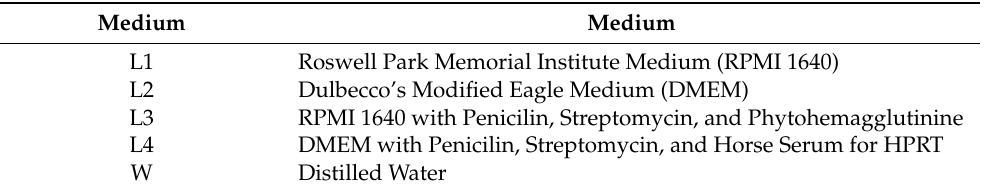
Table 1. Physiological media used to dissolve the Al 2 (SO 4 ) 3.